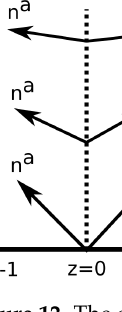
Figure 12. The effect of A → ∞ as t → ∞ on the null vectors along a z = constant curve.